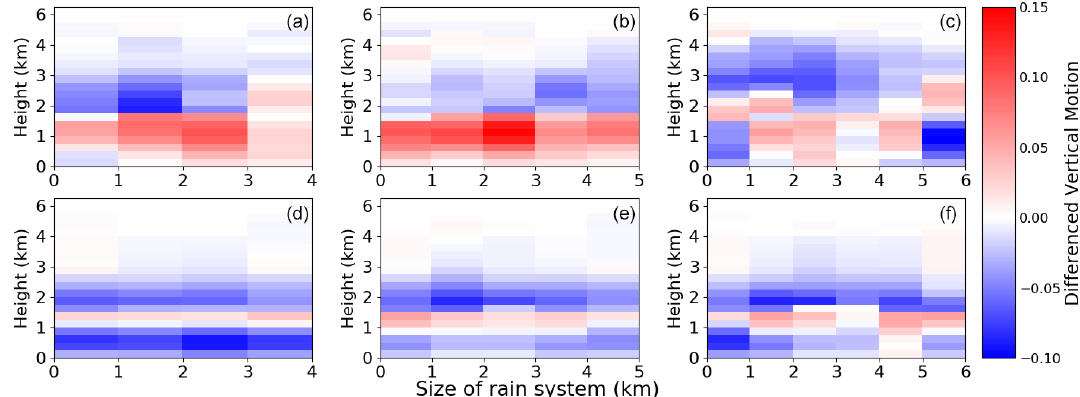
Figure 6. The difference (polluted – pristine) in vertical motion in unstable (a–c) and stable (d–f) environments for clouds of rain size 4km (a, d) , 5km (b, e) , and 6km (c, f) .